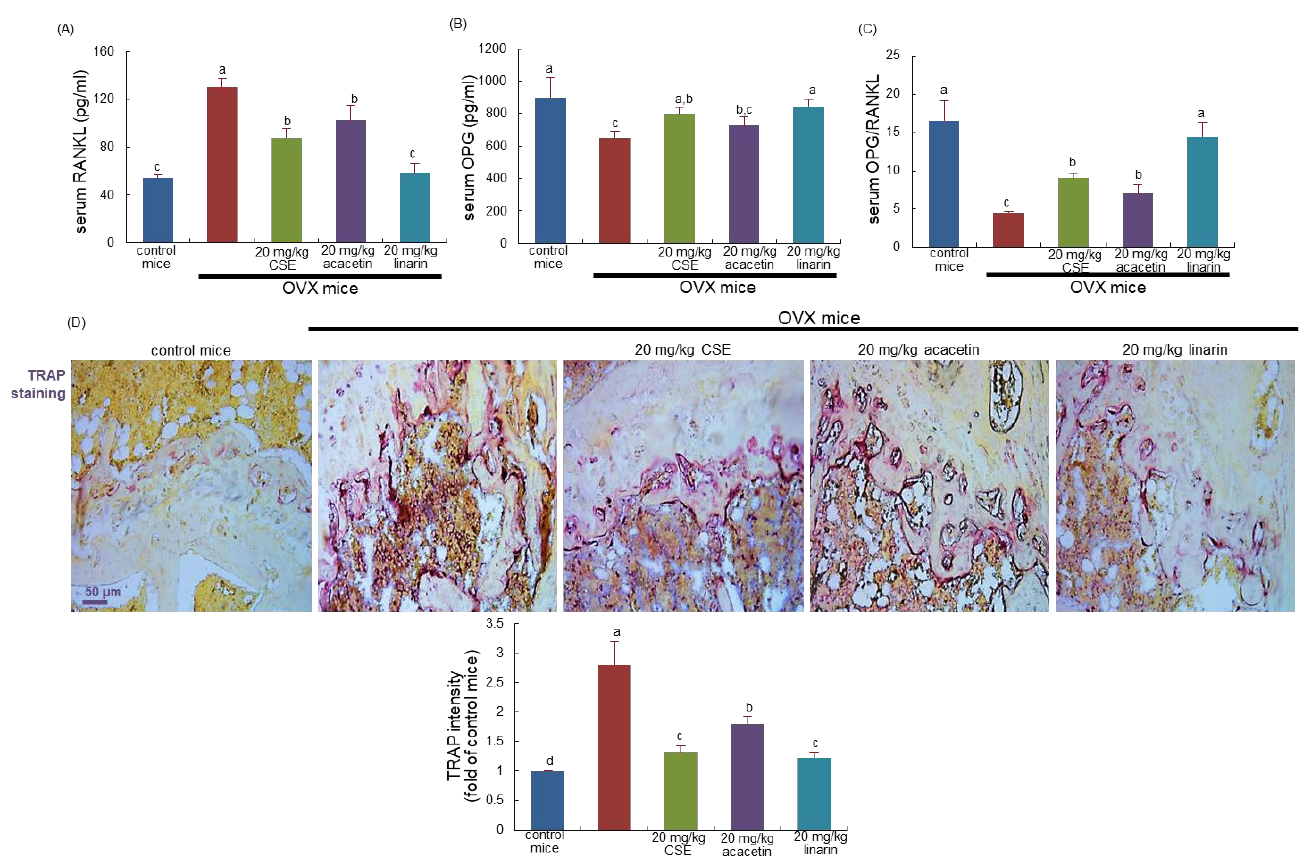
Figure 2. Circulating levels of receptor activator of nuclear factor kappa-B ligand (RANKL; A ) and osteoprotegerin (OPG; B ), OPG/RANK ratio ( C ), and tartrate-resistant acid phosphatase (TRAP) localization and activity ( D ) in ovariectomized (OVX) mice. OVX mice were orally supplemented with 20 mg/kg Cirsium setidens water extracts (CSEs), acacetin, or linarin daily for 8 weeks. The serum levels of RANKL and OPG were measured by employing enzyme-linked immunosorbent assay kits. Values in bar graphs (mean ± SEM, n = 4) not sharing a small alphabetical letter are different at p < 0.05. Longitudinal femoral bone tissues were stained with TRAP staining kits, and absorbance for TRAP intensity (mean ± SEM, n = 4) was measured at λ = 405 nm. Scale bar = 50 μm.